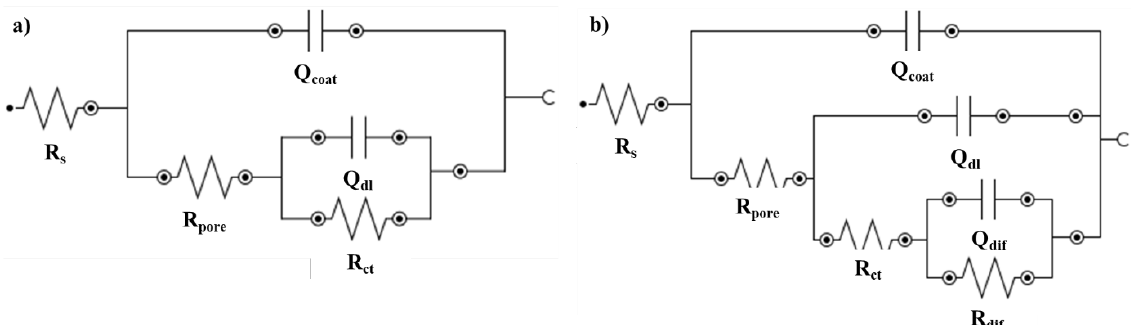
Figure 12. Equivalent circuits for the systems of ( a ) uncoated 1018 steel; coatings of ( b ) PANI/AR, SiO 2 -PANI/AR, CeO 2 -PANI/AR, and TiO 2 A-PANI/AR.